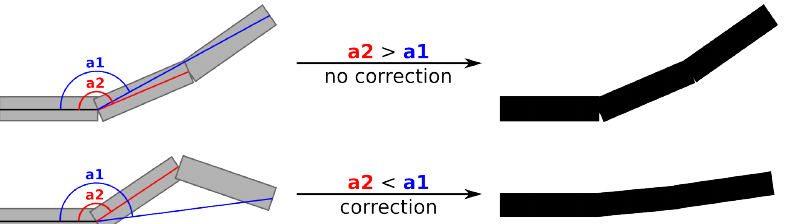
Figure 3. Illustration of the structure smoothing for three axis segments. If a modification is needed (i.e., the case illustrated at the bottom), the point that makes the junction between the second and third axis segments is moved to the averaged location between the base of the second and the tip of the third axis